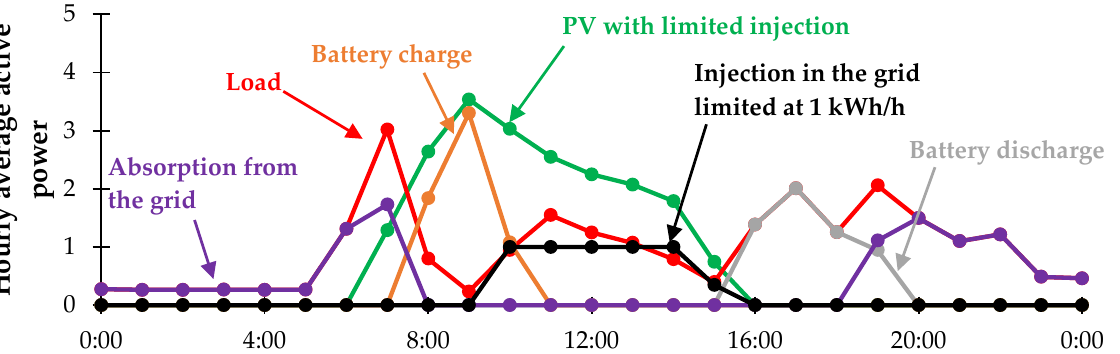
Figure 13. Hourly energy profiles of Figure 11 with a curtailment in the grid injection I.L. = 1 kWh/h. The energy quota that cannot be injected into the grid is wasted; in this example, the PV production is 22% less. This wasted energy cannot be sold or used in the annual